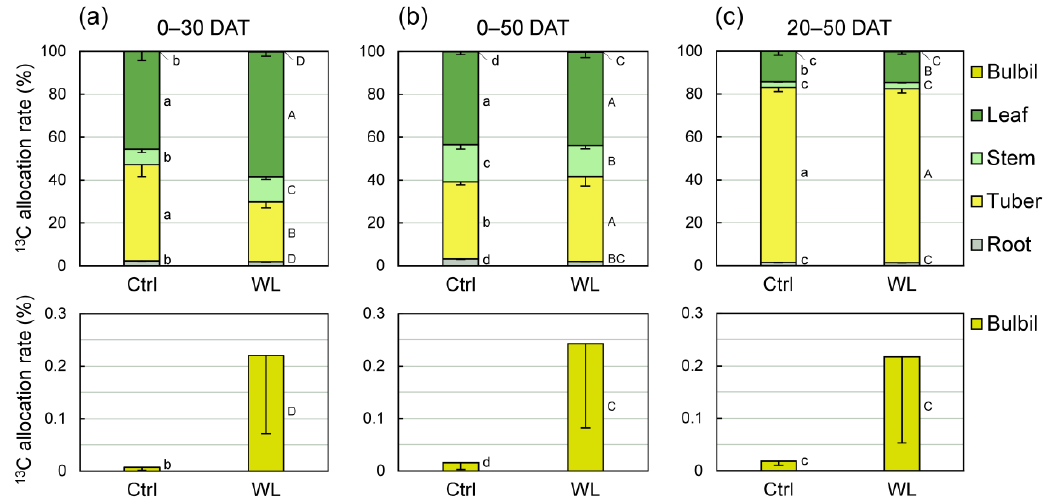
Figure 6. Comparison of 13 C-photoassimilate allocation rates between control (Ctrl) and waterlogged (WL) soil conditions at ( a ) 30 and ( b , c ) 50 days after treatment (DAT). 13 CO 2 was applied to whole shoot at ( a , b ) 0 and ( c ) 20 DAT. Values are the means ± S.E. of three replications derived from different plants. Bars followed by the same letter represent no significant difference in each organ by Tukey’s test at the 5% level.